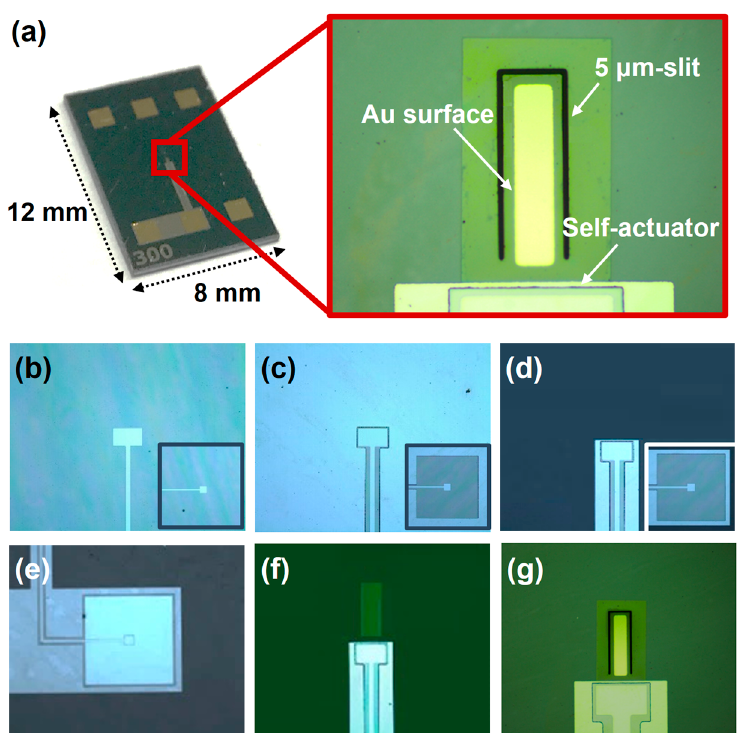
Figure 2. Optical images of the slit cantilever and fabrication process ( a ) a single die of the slit cantilever sensor and fabrication details for ( b ) upper Pt etching; ( c ) PZT wet-etching; ( d ) bottom Pt etching; ( e ) Au contact pad formation; ( f ) backside-Si bulk etching; and ( g ) biological active layer formation and cantilever releasing.